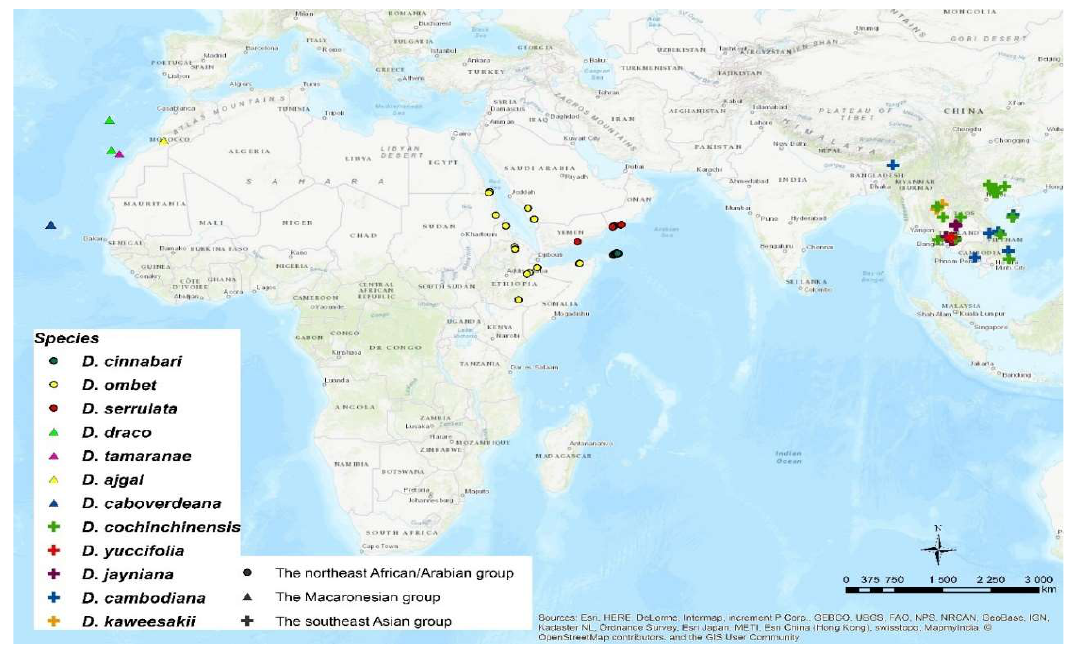
Figure 1. Geographic distribution of individual dragon tree species, the points show locality of occurrence based on published sources cited in this Section 2.3.